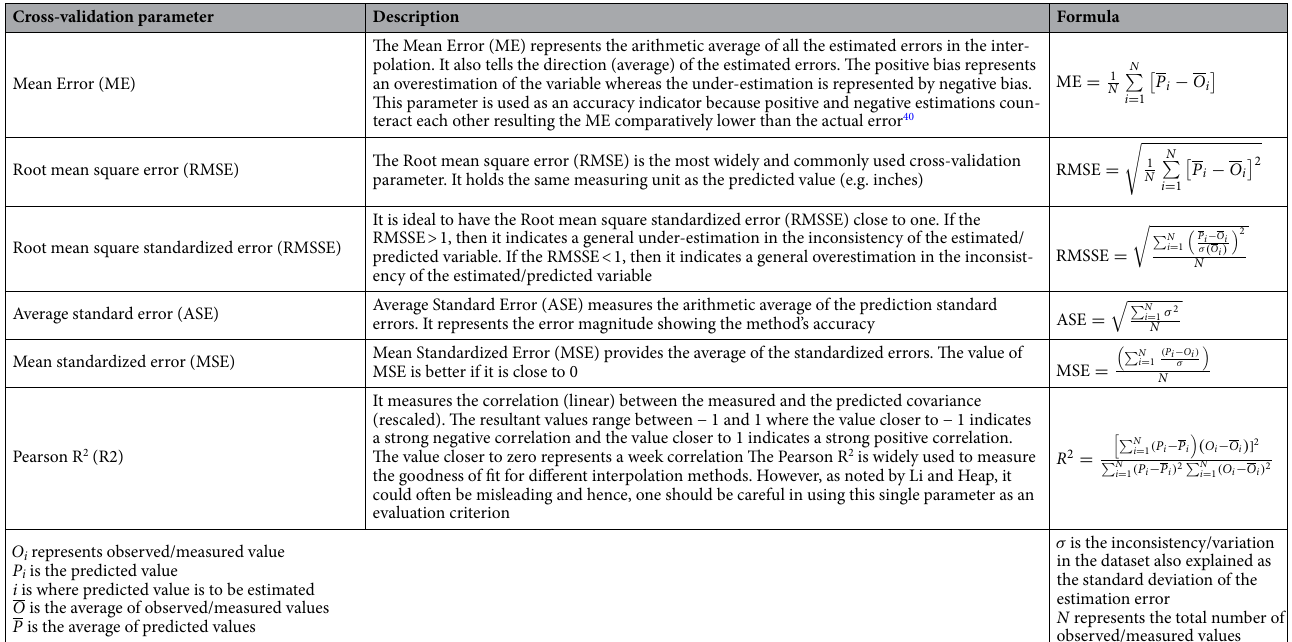
the standard deviation of the estimation